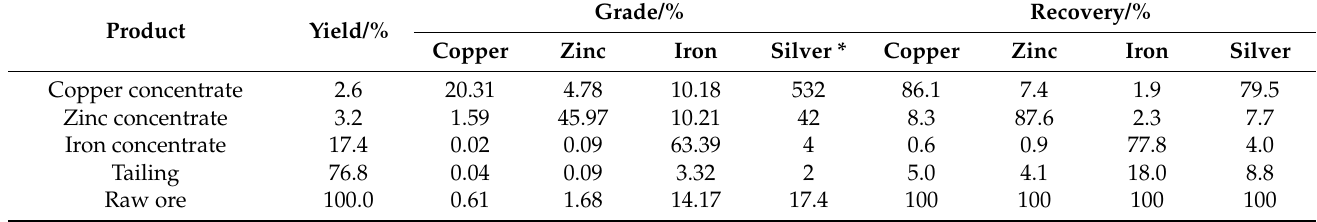
Table 9. The results of the closed-circuit experiment of the developed comprehensive recovery process.